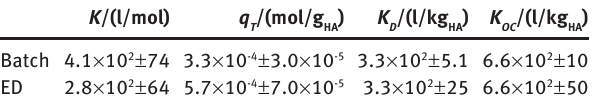
Table 1 Langmuir coefficients ( K ), the maximum bound amounts ) and organic of 2,2′-bipyridine (BP) ( qT ), distribution coefficient ( K D carbon distribution coefficient ( K ) values obtained from the batch OC and equilibrium dialysis (ED) experiments (background electrolyte: 10 -2 mol/l CaCl , pH = 6.1–6.3, at room temperature). In order to 2 make results comparable to the McCall classification the K values D were multiplied by 10 3